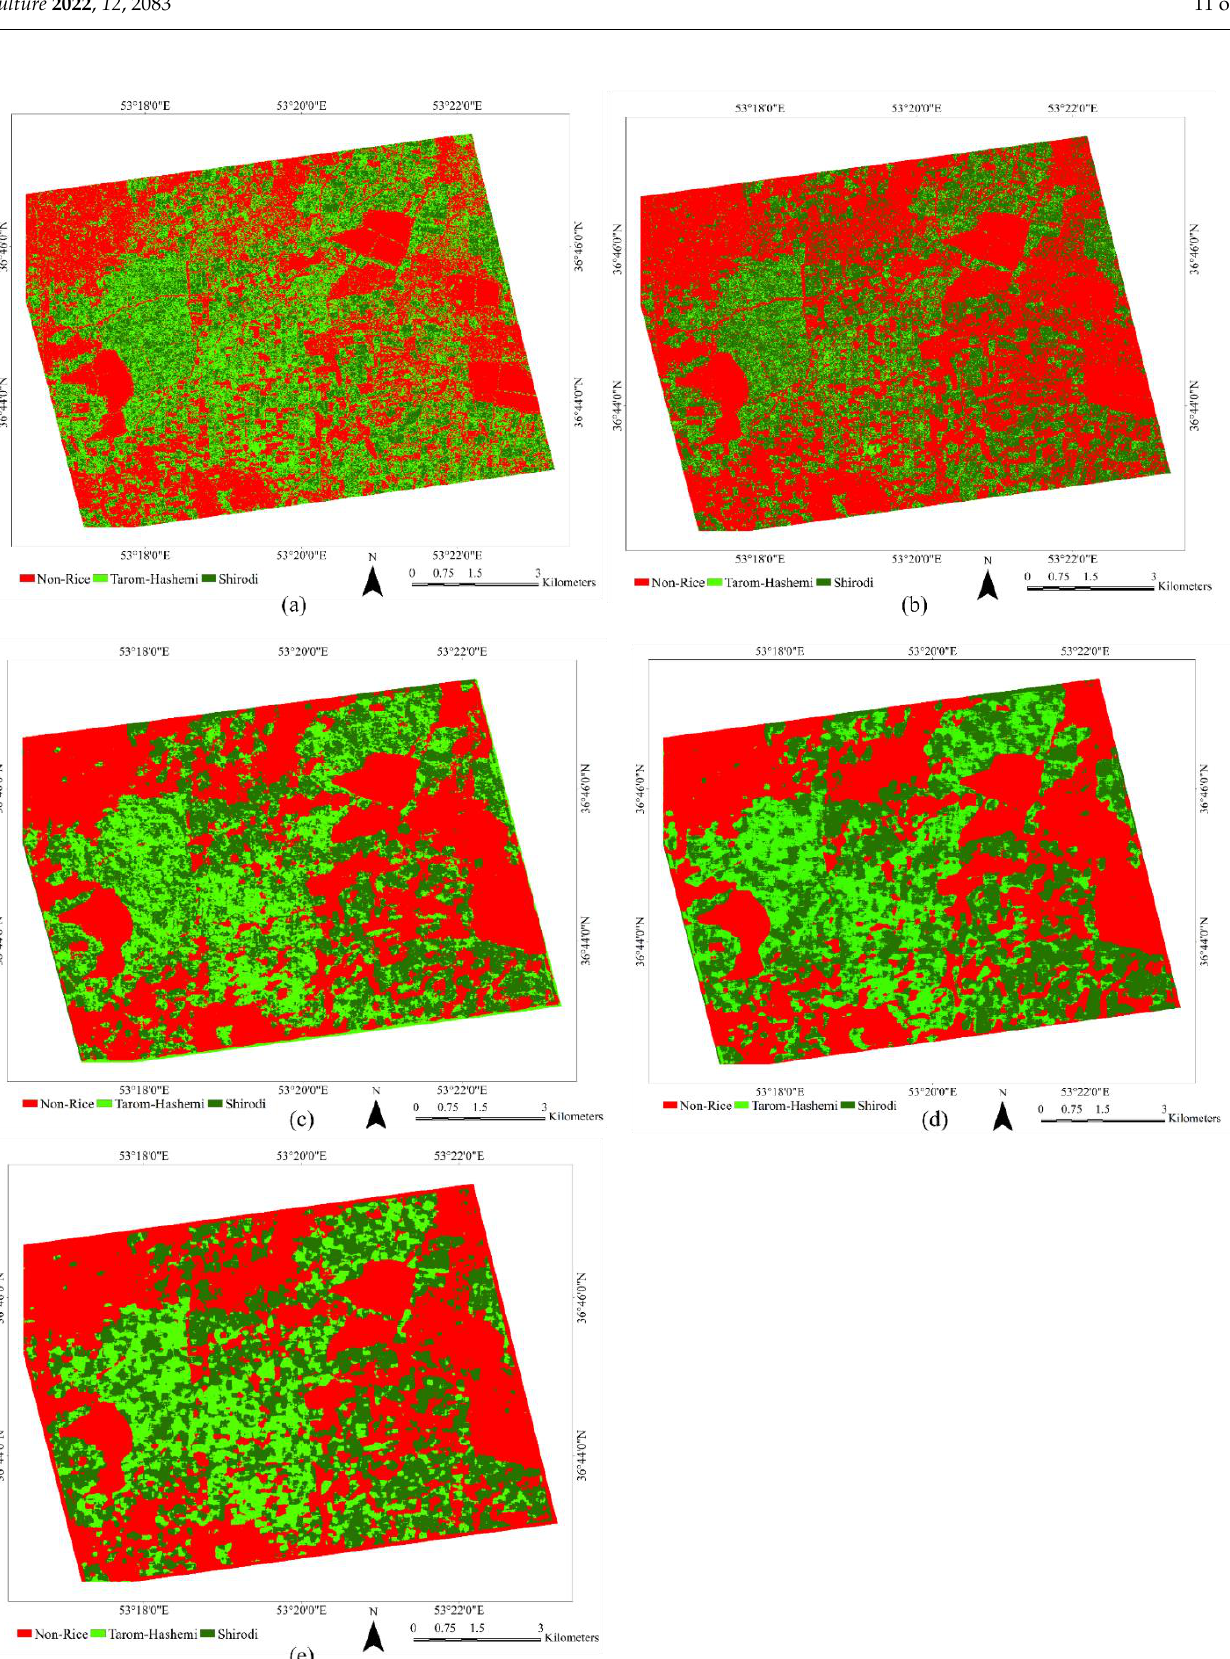
Figure 8. Comparison of the rice variety maps produced using the proposed classification algorithm and other methods: ( a ) RF, ( b ) XGBOOST, ( c ) 2-CNN, ( d ) 3-CNN, and ( e ) the proposed method.